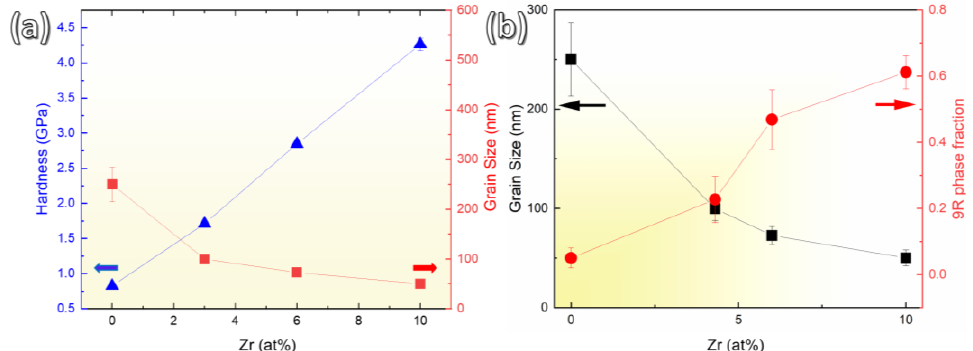
Figure 3. ( a ) Hardness and grain size plotted as a function of Zr solute concentration. ( b ) Plot detailing the evolution of grain size and 9R phase fraction with the concentration of Zr.